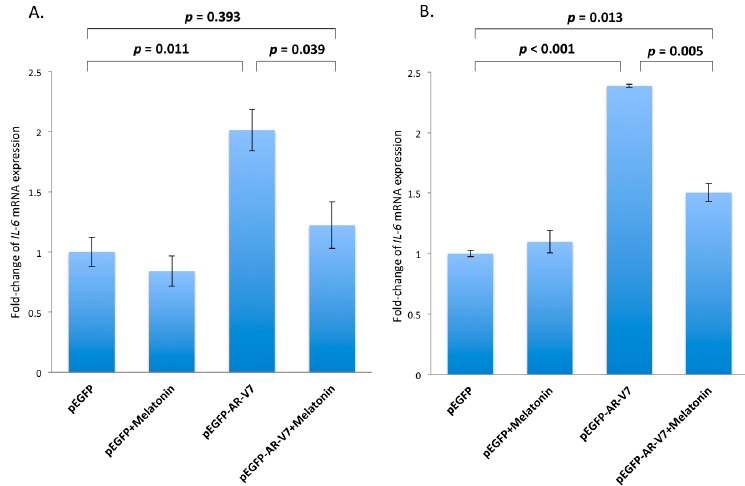
Figure 5. Q-PCR analysis of interleukin (IL)-6 expression in transfected prostate cancer cells. LNCaP ( A ) and 22Rv1 ( B ) cells were transfected with pEGFP or pEGFP-AR-V7 expression plasmids, in the presence or absence of melatonin (10 − 6 M) for 24 h. The relative levels of IL-6 were compared using cells transfected with pEGFP as a control. Data are shown as relative fold-change of IL-6 mRNA expression ± S.E.